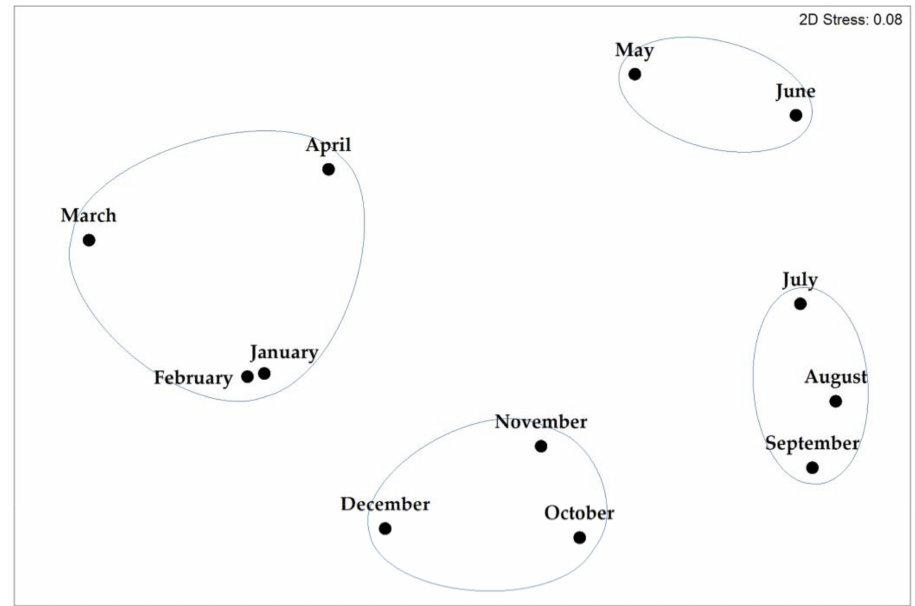
Figure 7. Multidimensional scaling plot (MDS) of Bray–Curtis similarity, based on the monthly probability of occurrence of each Thalassiosira species in the HTS dataset. Four seasonal groups are apparent at the 70% similarity level: winter (January–April), spring (May–June), summer (July–September), and fall (October–December).